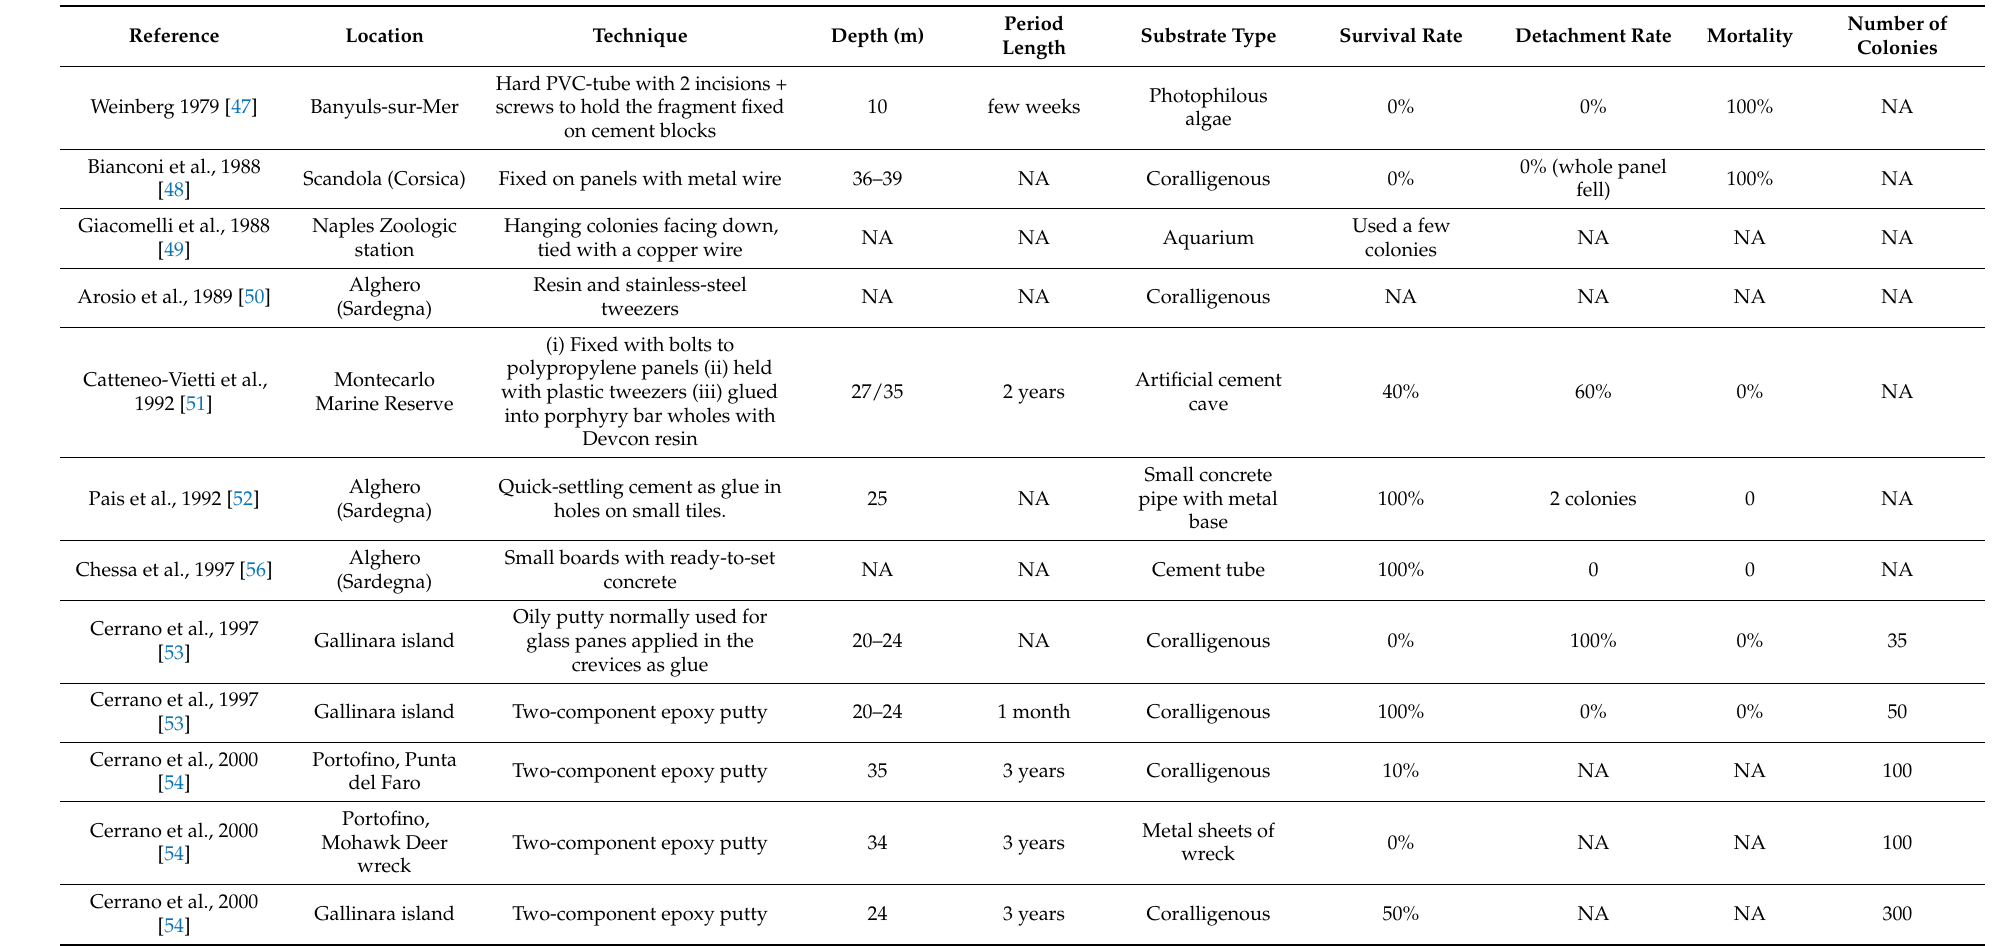
Table A1. List of articles considered to summarize C. rubrum transplantation